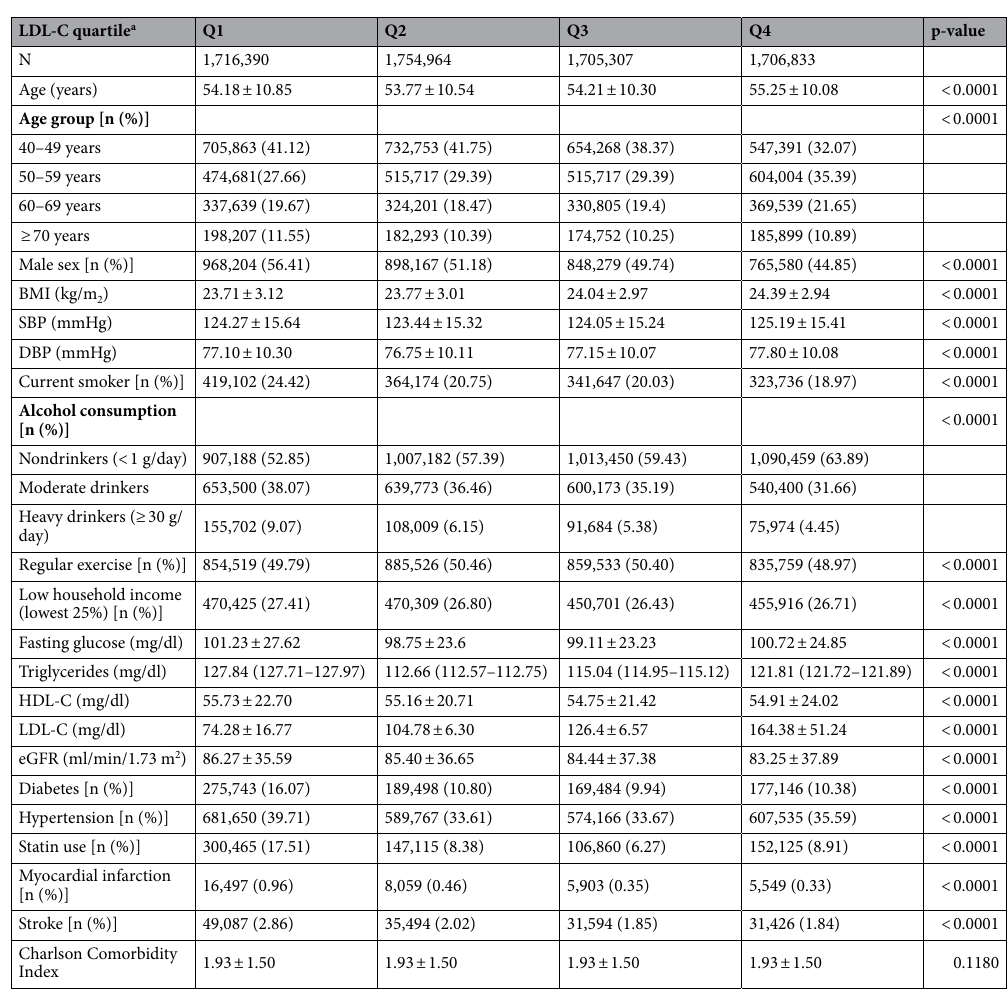
Table 1. Baseline characteristics according to quartile of low-density lipoprotein cholesterol level. Values are presented as number (%), mean ± standard deviation, or geometric mean (95% confidence